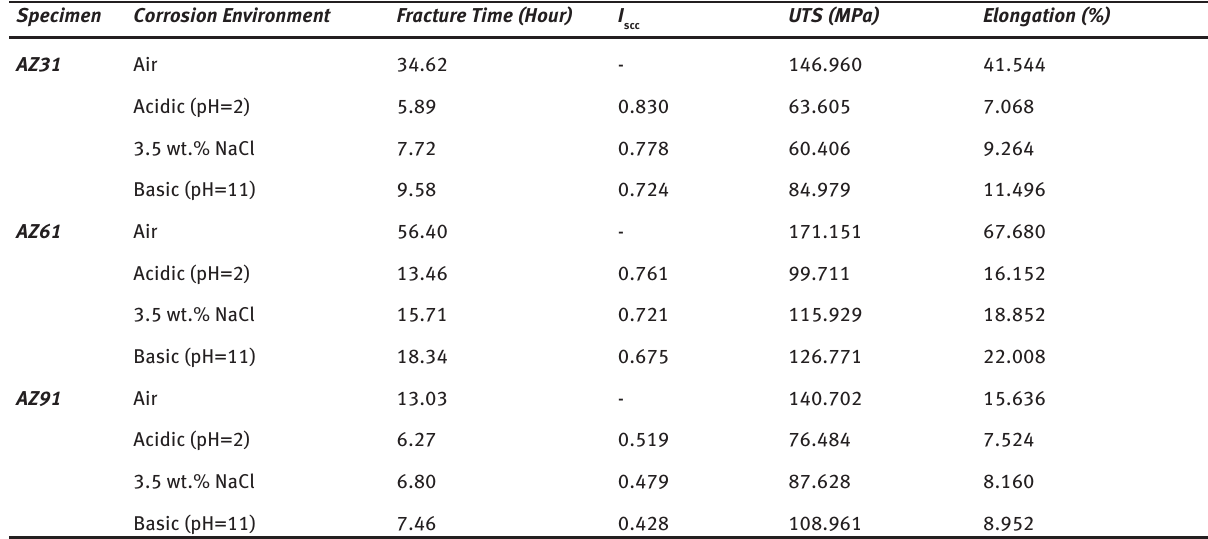
Table 2: SSRT results of magnesium alloys. Specimen Corrosion